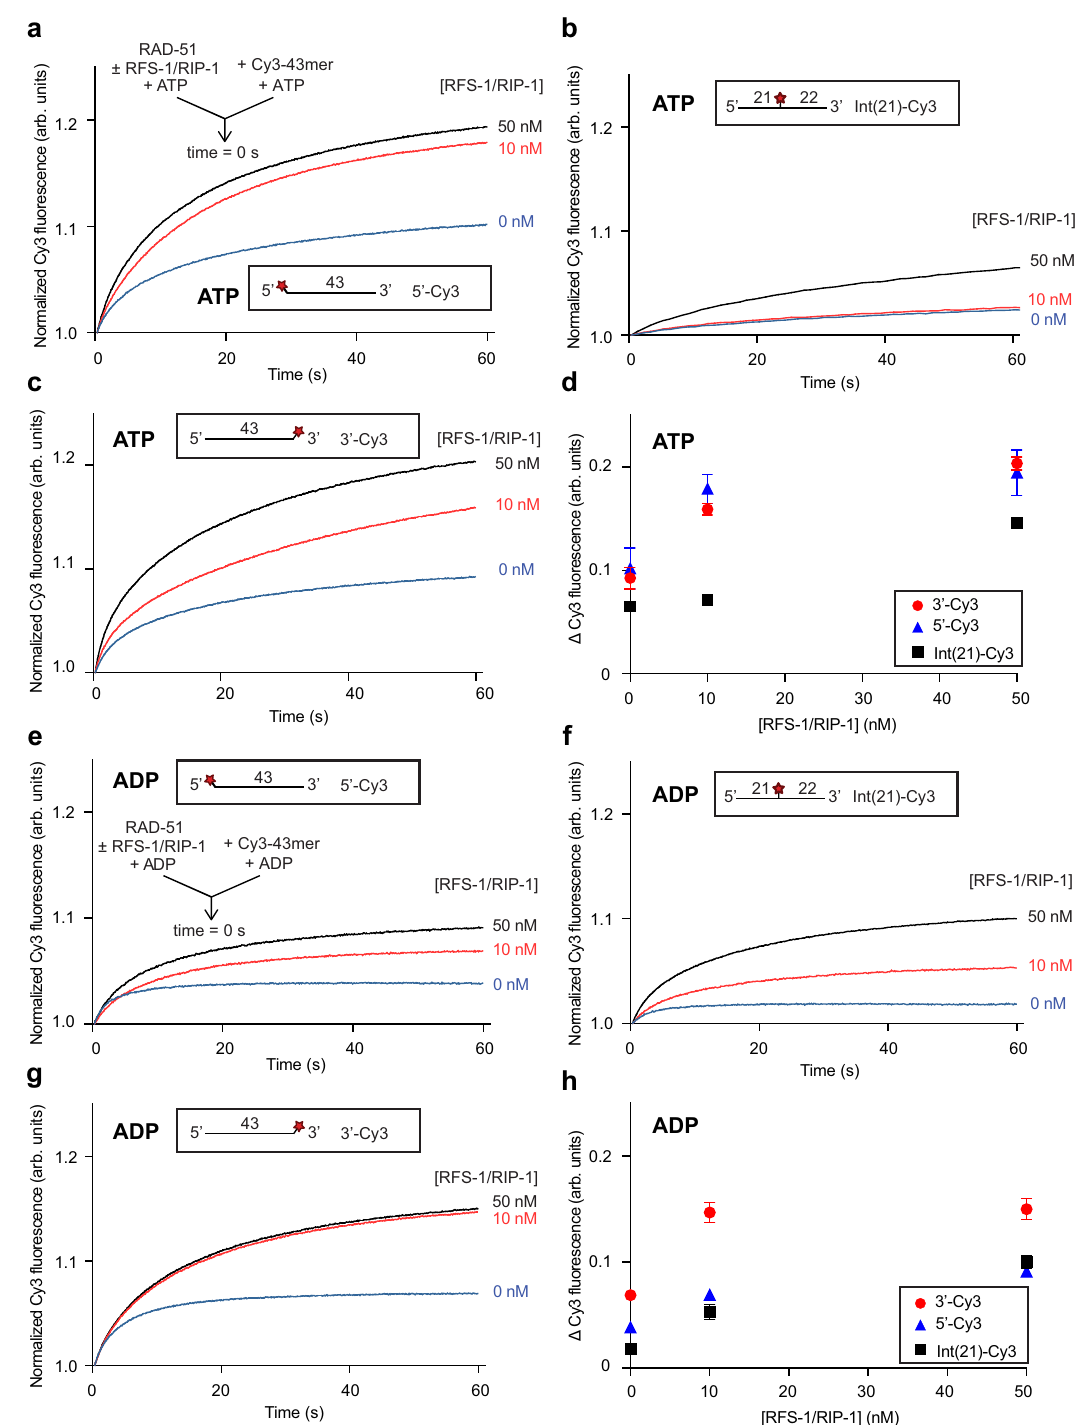
Fig. 1 RFS-1/RIP-1 stimulates formation of RAD-51-ssDNA fi laments in the presence of ATP or ADP. Average normalized Cy3-43mer fl uorescence pro fi les plotted as a function of time. The arrow indicates the components of the two syringes rapidly mixed at the 0 s time point in a stopped fl ow instrument. In all experiments RAD-51 (250 nM) alone or in the presence of RFS-1/RIP-1 (10 and 50 nM) was mixed with Cy3-43mer ssDNA (15 nM). a and e 5 ′ -Cy3, ( b and f ) Int(21)-Cy3 or ( c and g ) 3 ′ -Cy3 labelled substrates were used ( a : n = 5, b : n = 4 – 5, c : n = 4 – 5, e : n = 4, f : n = 4 – 8, g : n = 5 – 6). Schematics of these different Cy3 label positions are shown inset. d and h Graphs of RFS-1/RIP-1 concentration-dependence of average Δ Cy3 fl uorescence for the data presented in ( a – c ) and ( e – g ) respectively (mean; errors: s.d.). Experiments in ( a – d ) were performed in the presence of ATP, whereas ( e – h ) were performed with ADP. Source data are provided as a Source Data fi